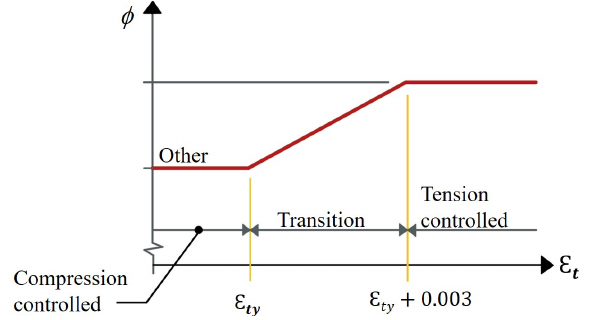
Fig. 2. Variation of ϕ with net tensile strain in extreme tension reinforcement ε t